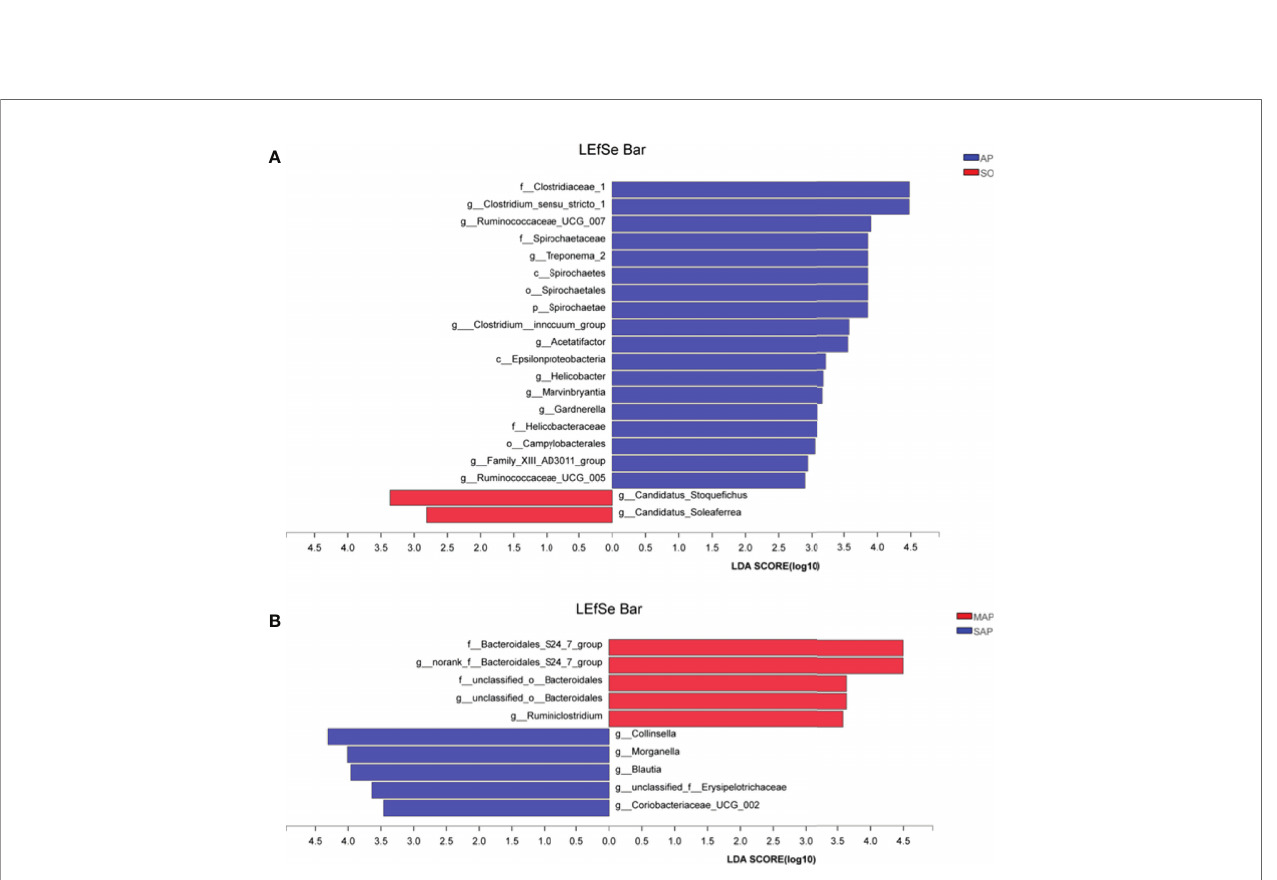
FIGURE 5 | LDA Effect Size (LEfSe) algorithm was applied, on phylum to genus level OTU tables to determine taxa, which is best characterized as each biological class. (A) The difference between samples of AP to SO rat. (B) The difference between the samples of MAP to SAP rats. SO, Sham operation; MAP, Mild acute pancreatitis; SAP, Severe acute pancreatitis; LDA, linear discriminant analysis. AP indicates MAP plus